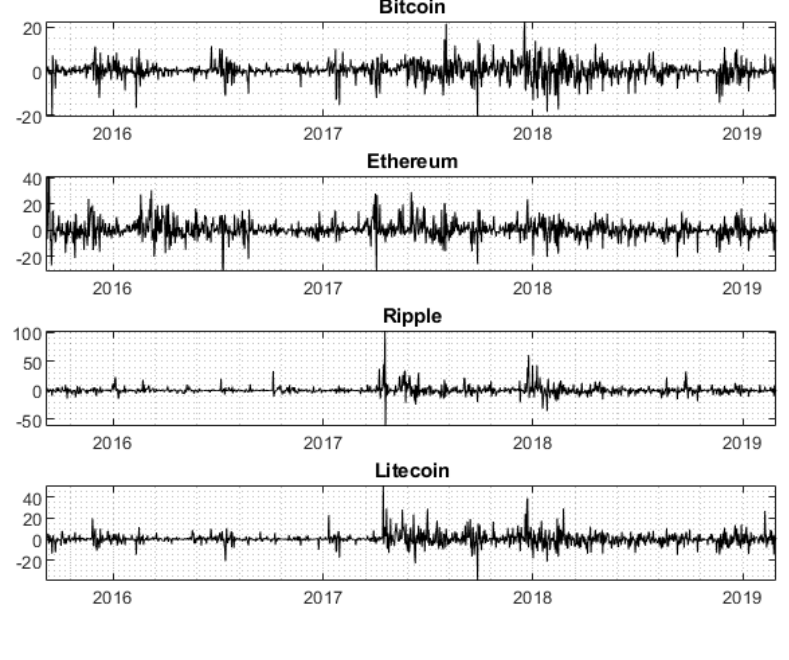
Figure 2. Daily log returns of the four